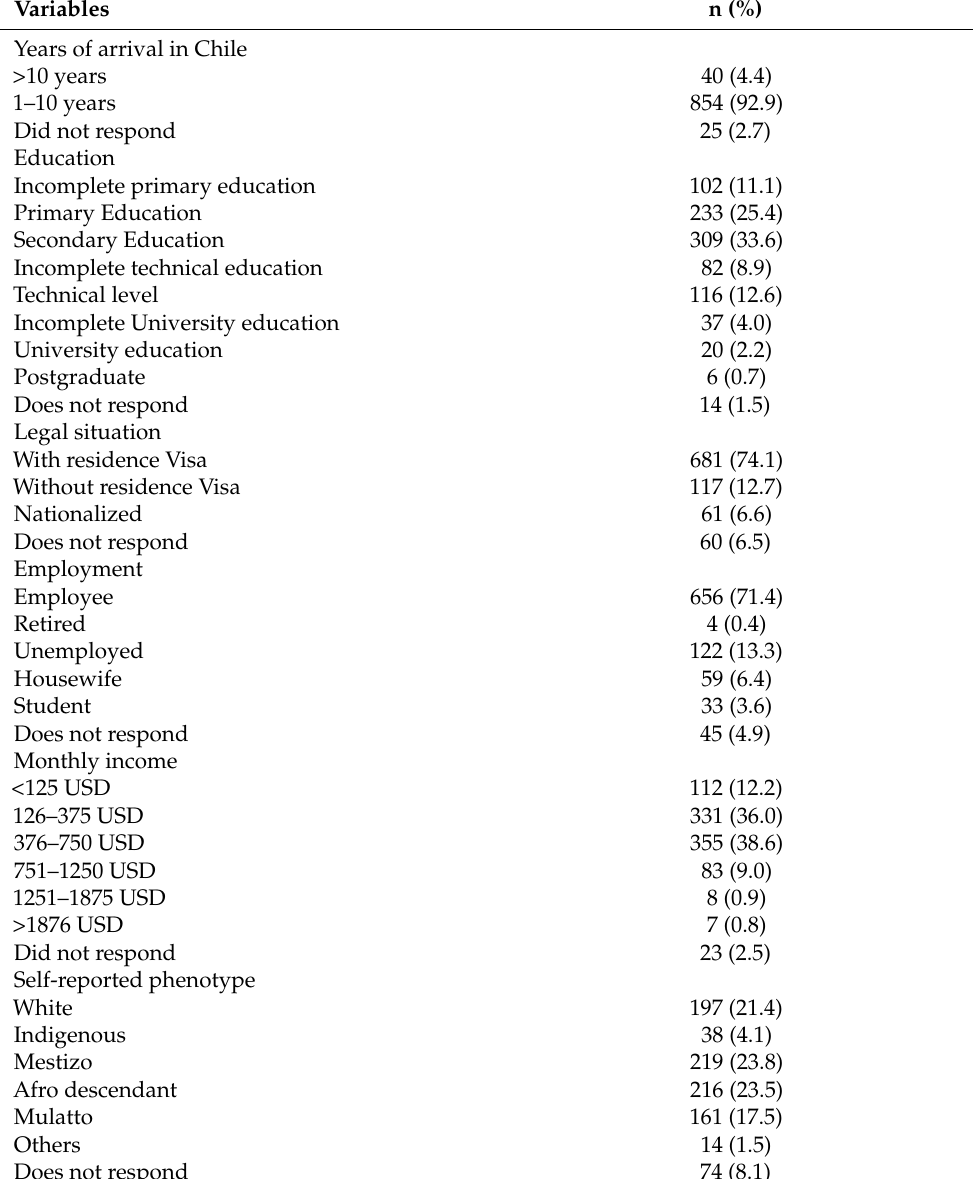
Table 1. Sociodemographic characteristics of